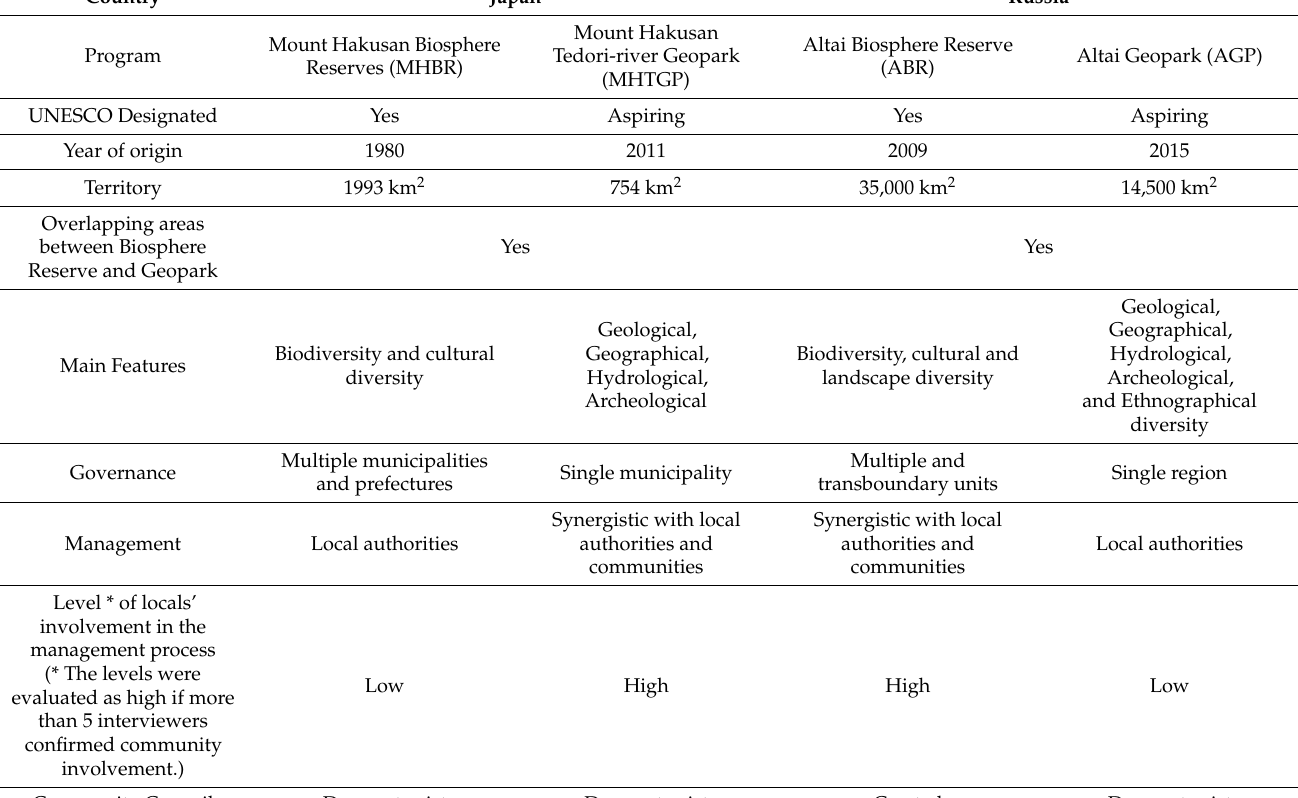
Table 2. Differences between the Russian ABR and AGP, and the Japanese MHBR and